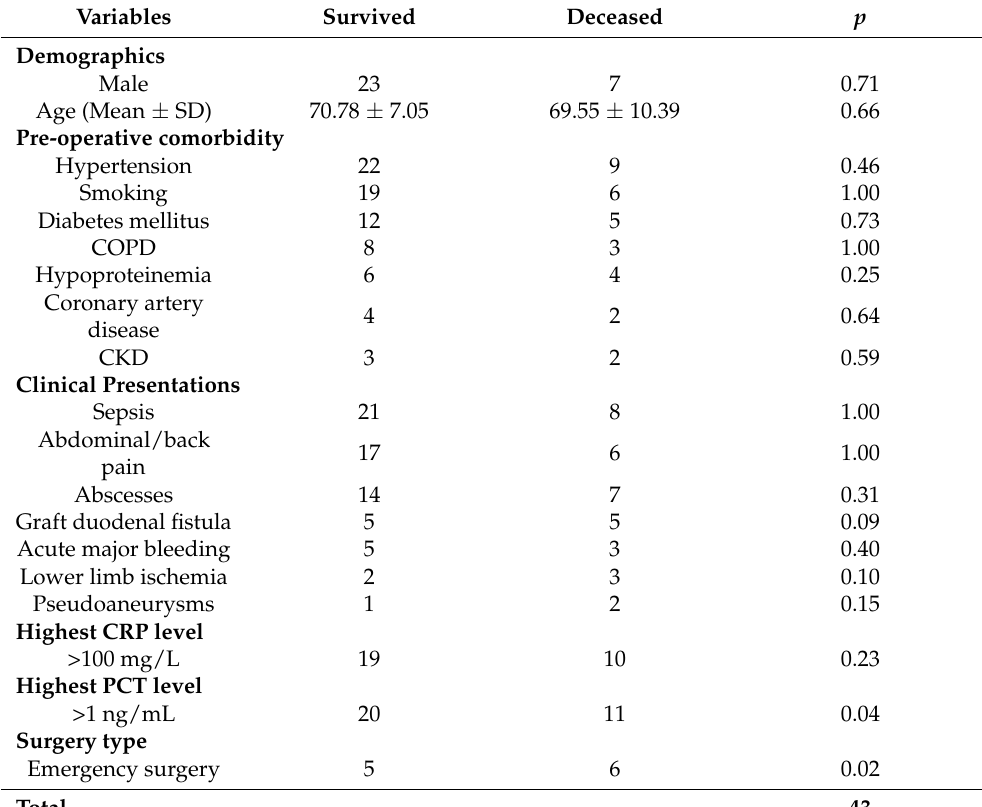
Table 4. Univariate analysis of risk factors associated with 30-day mortality.